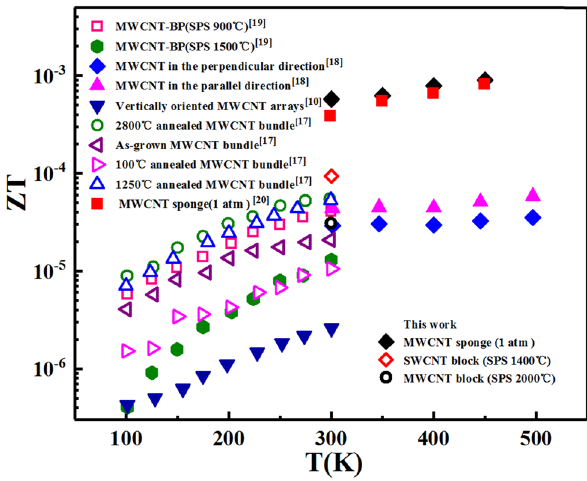
Figure 6: Comparison of temperature dependence of ZT values for samples prepared in this paper and other macroscopic pure CNTs